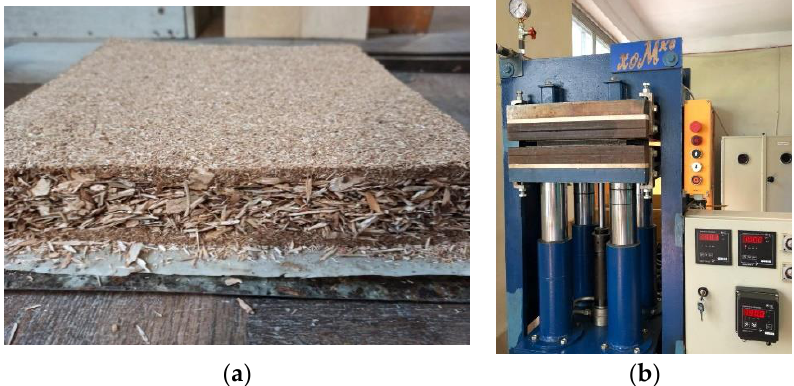
Figure 2. The formed particle mattress ( a ) and hydraulic laboratory press ( b ). Table 2. Manufacturing parameters of particleboards produced in this work.